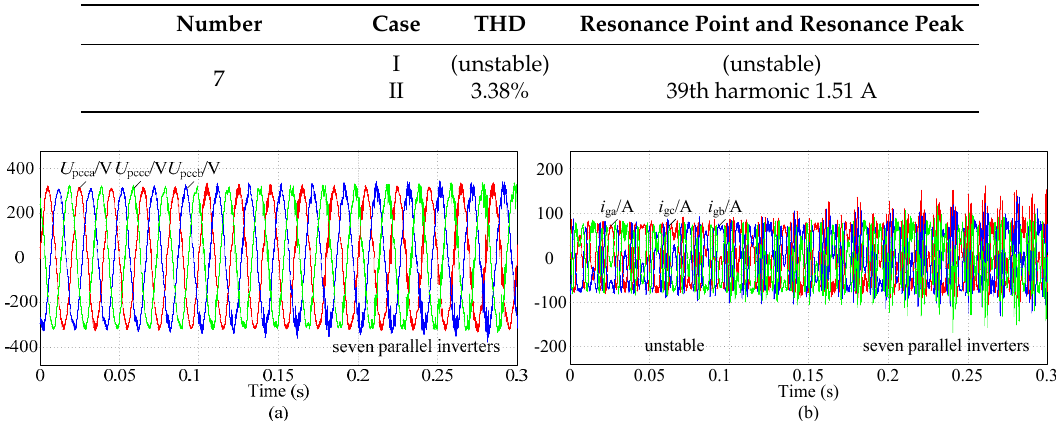
Figure 14. Simulation waveforms of PCC voltage u PCC and the grid-connected current i g in case I (seven parallel inverters). ( a ) PCC voltage u PCC ; ( b ) grid-connected current i g .